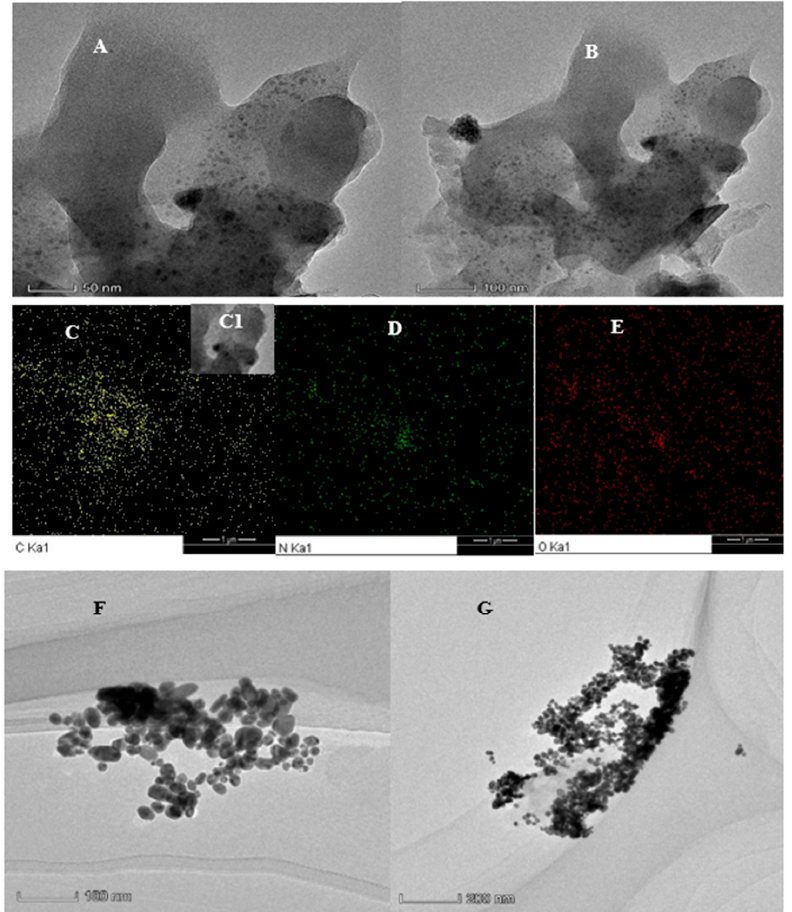
Figure 2. ( A , B ) TEM image of DdBd. ( C – E ) The mapping image of DdBd. ( C1 ) TEM image of the element mapping part. ( F ) TEM image of 80.0 mg/L HAuCl 4 + 0.230 mmol/L HCl + 149 g/L PEG + 0.300 mmol/L DdBd + 6.70 pmol/L Apt OTC + 0.625 μ mol/L VBB. ( G ) TEM image of F + 4.00 × 10 − 2 nmol/L OTC.